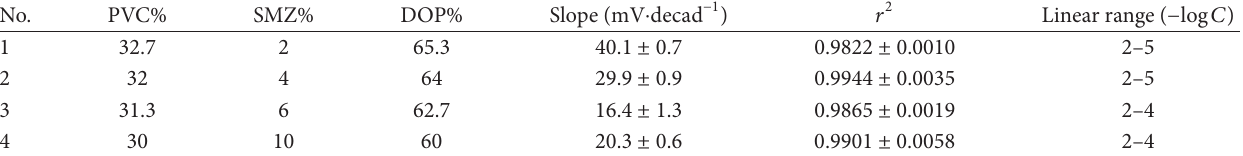
T 3: Effect of SMZ-PVC membrane composition on the potentiometric behavior of the chromate-selective electrode (